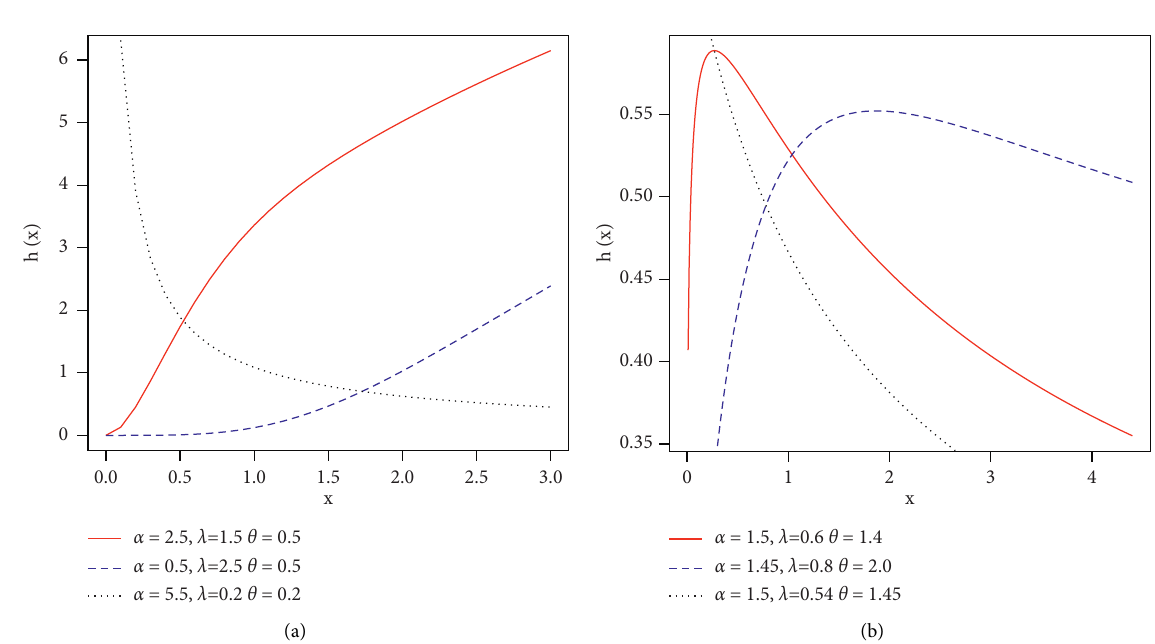
Figure 2: Plots of hazard functions for different values of parameters.